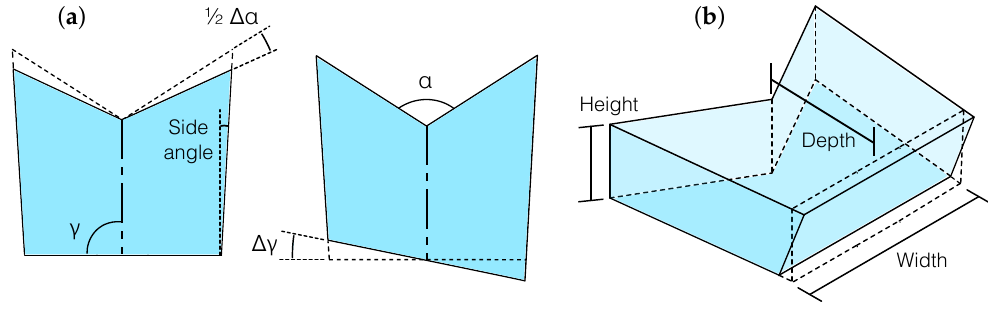
Figure 4. Critical manufacturing tolerances are divided into two categories. Tolerances affecting the relative alignment between optical surfaces, parameterized by α and γ ( a ), lead to in-plane beam misalignments that can be compensated for in both interferometers by tuning the direction of the incident beams; tolerances affecting the perpendicularity of the optical surfaces with respect to the prism base ( b ) cause off-plane beam misalignments and result in an unavoidable loss of interferometric